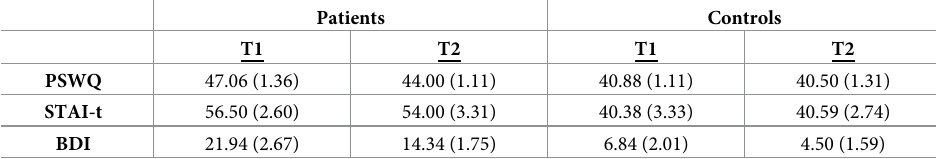
Table 1. Average scores in the